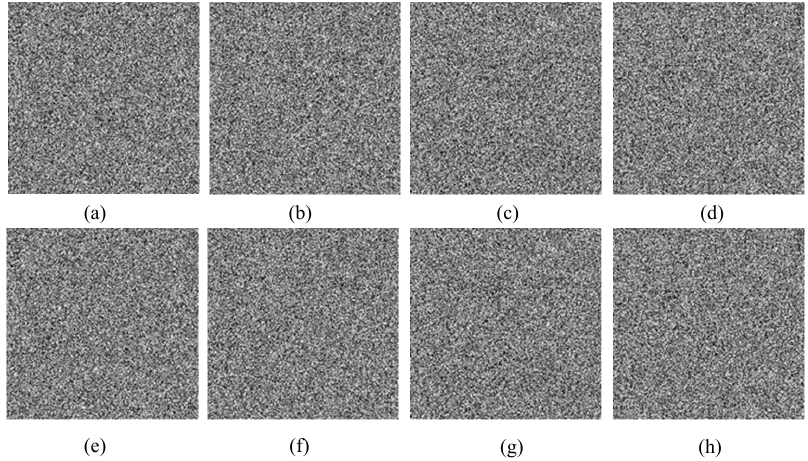
Figure 6. The ciphertext images of eight fringe images. ( a – d ) The ciphertext images of four original fringe images; ( e – h ) the ciphertext images of four deformed fringe images.